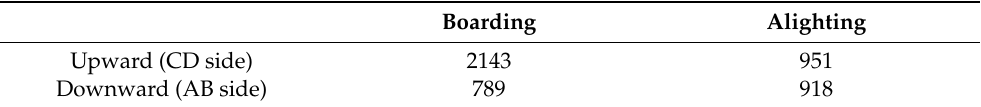
Table 2. Statistics of pedestrians’ information during one weekday morning off-peak hour. Boarding